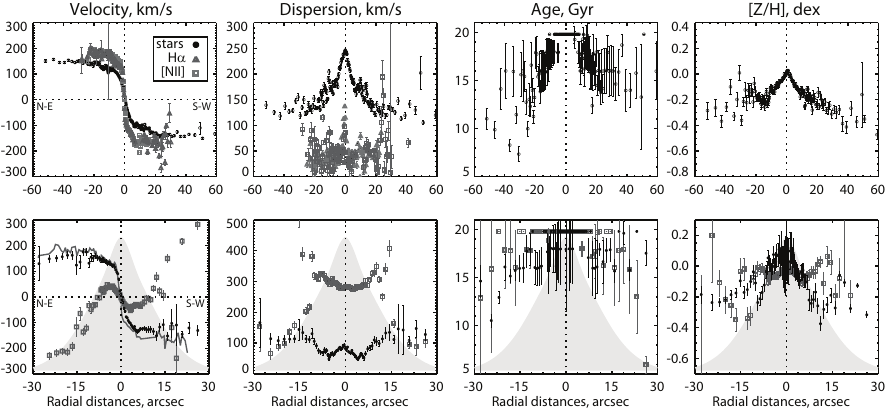
Fig. 3. SCORPIO long-slit spectroscopic data. Upper row: single component spectral fitting ( S=N = 20) in the ‘green’ spectral domain. Lower row: two-component spectral fitting ( S=N = 40). Black points and grey squares correspond to the ‘disk’ and ‘bulge’ components, respectively, the grey line shows the H(cid:11) kinematics and the light grey shaded region presents a relative bulge